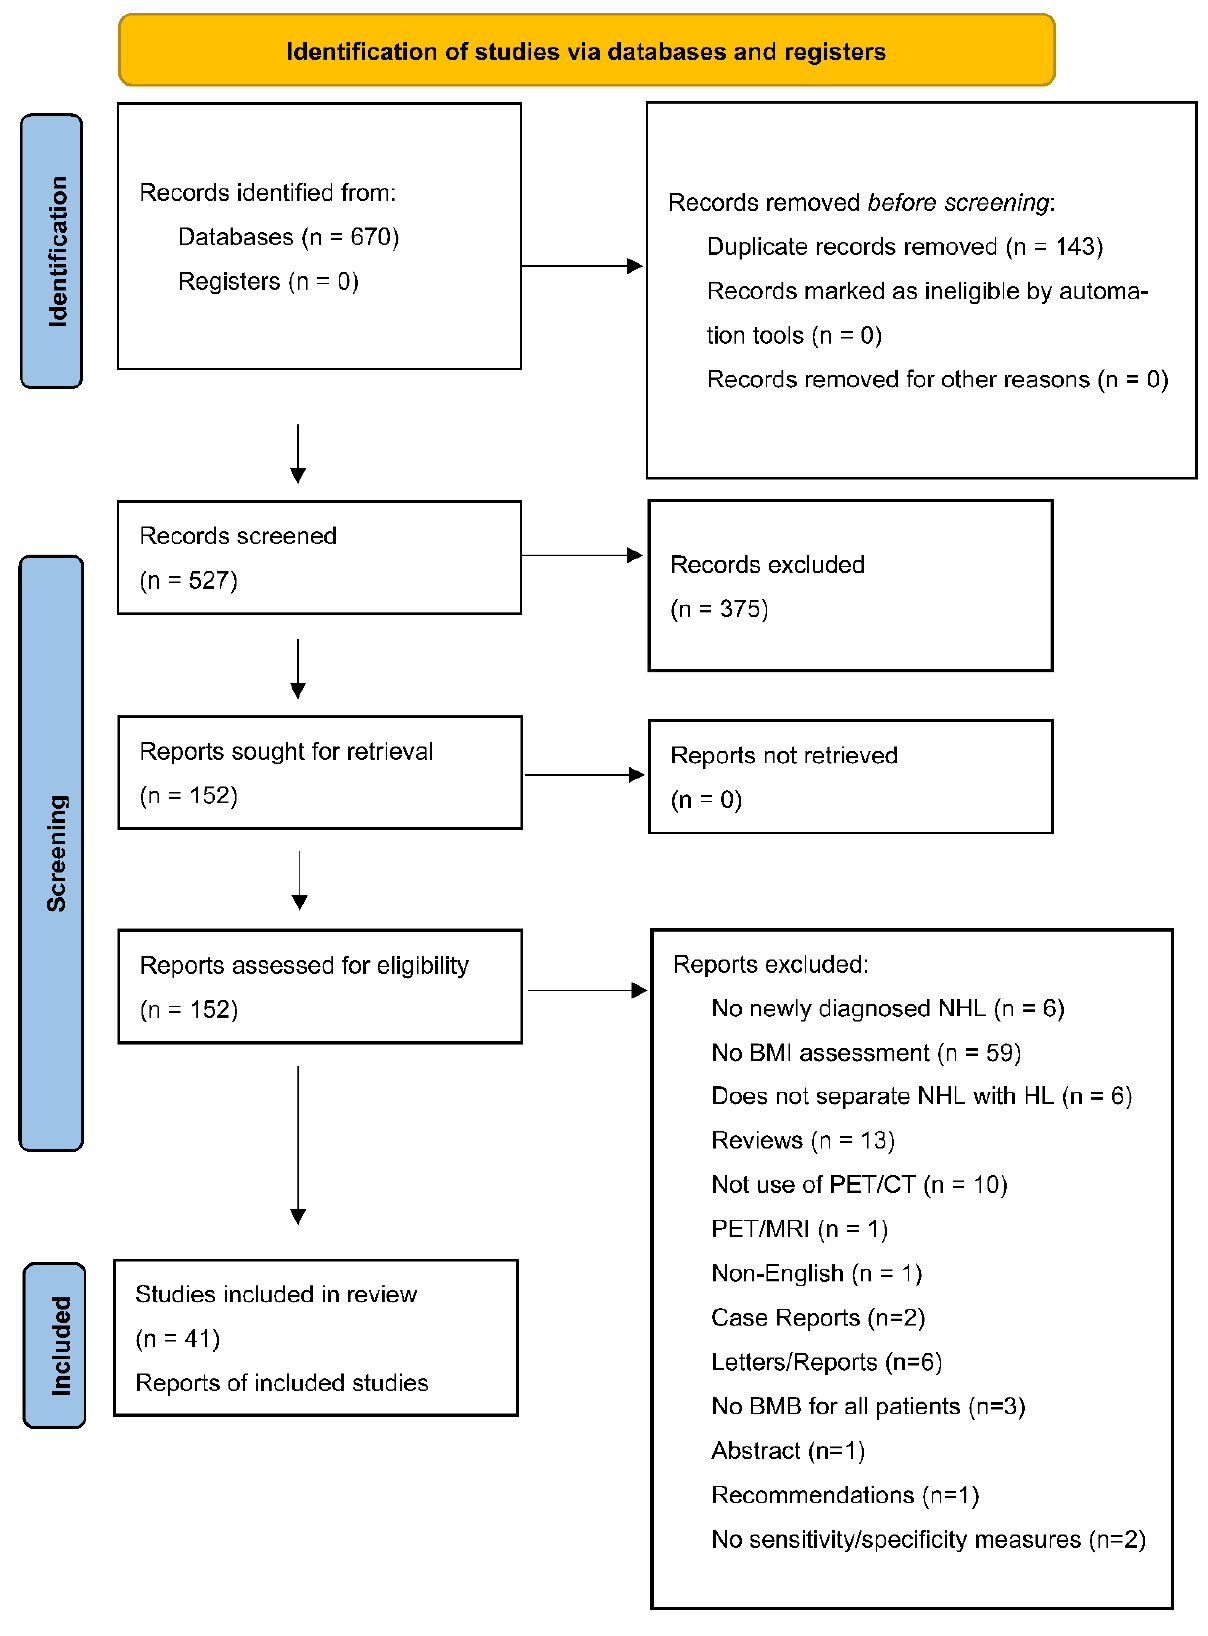
Figure 1. Flow diagram of the search process.